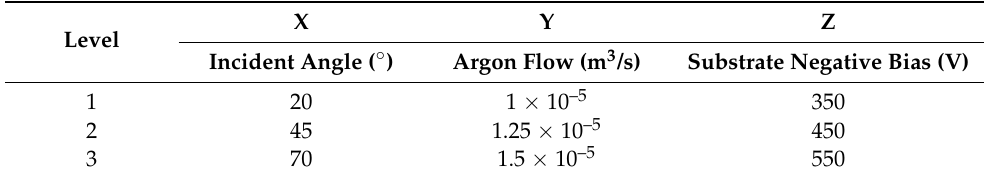
Table 7. Level table of orthogonal test factors of ion beam etching.